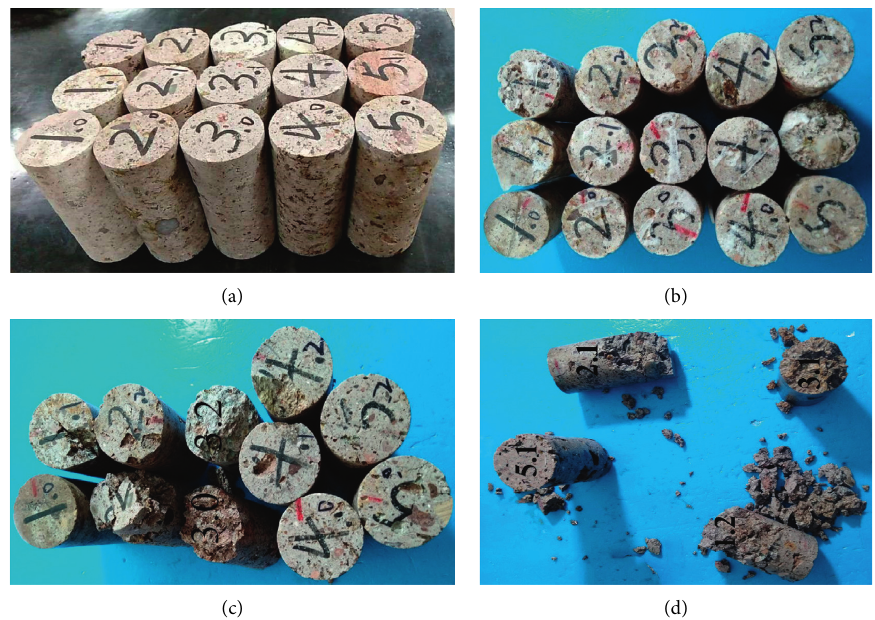
Figure 3: Sample preparation. (a) The samples that have not undergone a freeze-thaw cycle after being saturated with water under a vacuum; (b) the samples in the freezing stage during the 150th freeze-thaw cycle; (c) and (d) the samples after 150 freeze-thaw